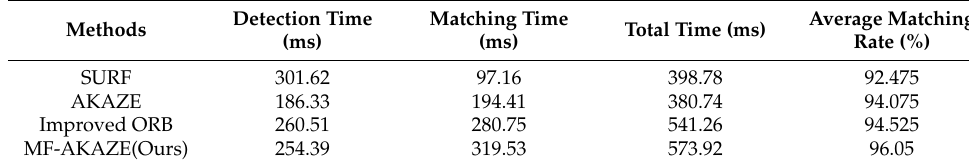
Table 4. Comparison of time consumption and average matching